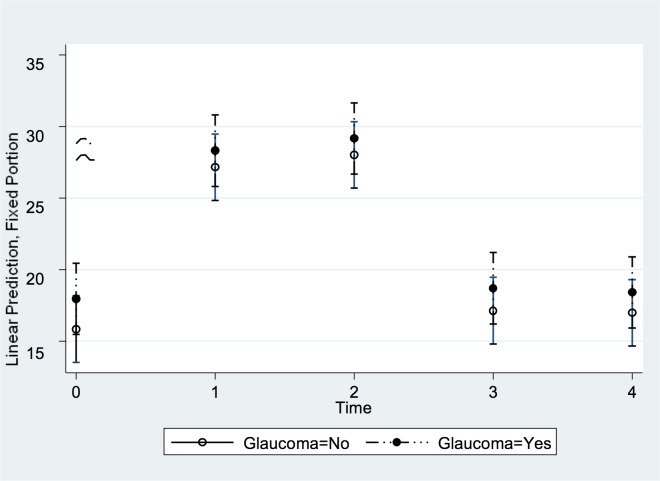
Least squares means and mean values of the covariates of the changes in IOP in the Adho Mukha Svanasana position over time.The X axis represents each time point an IOP measurement was taken (0 = Baseline seated; 1 = Immediate position; 2 = 2 minutes position; 3 = Post position seated; and 4 = 10 minutes post position seated). The Y axis represents the IOP in mmHg after adjusting for the covariates. Subjects with glaucoma diagnosis are depicted ‘Glaucoma = 1’; controls are ‘Glaucoma = 0’.